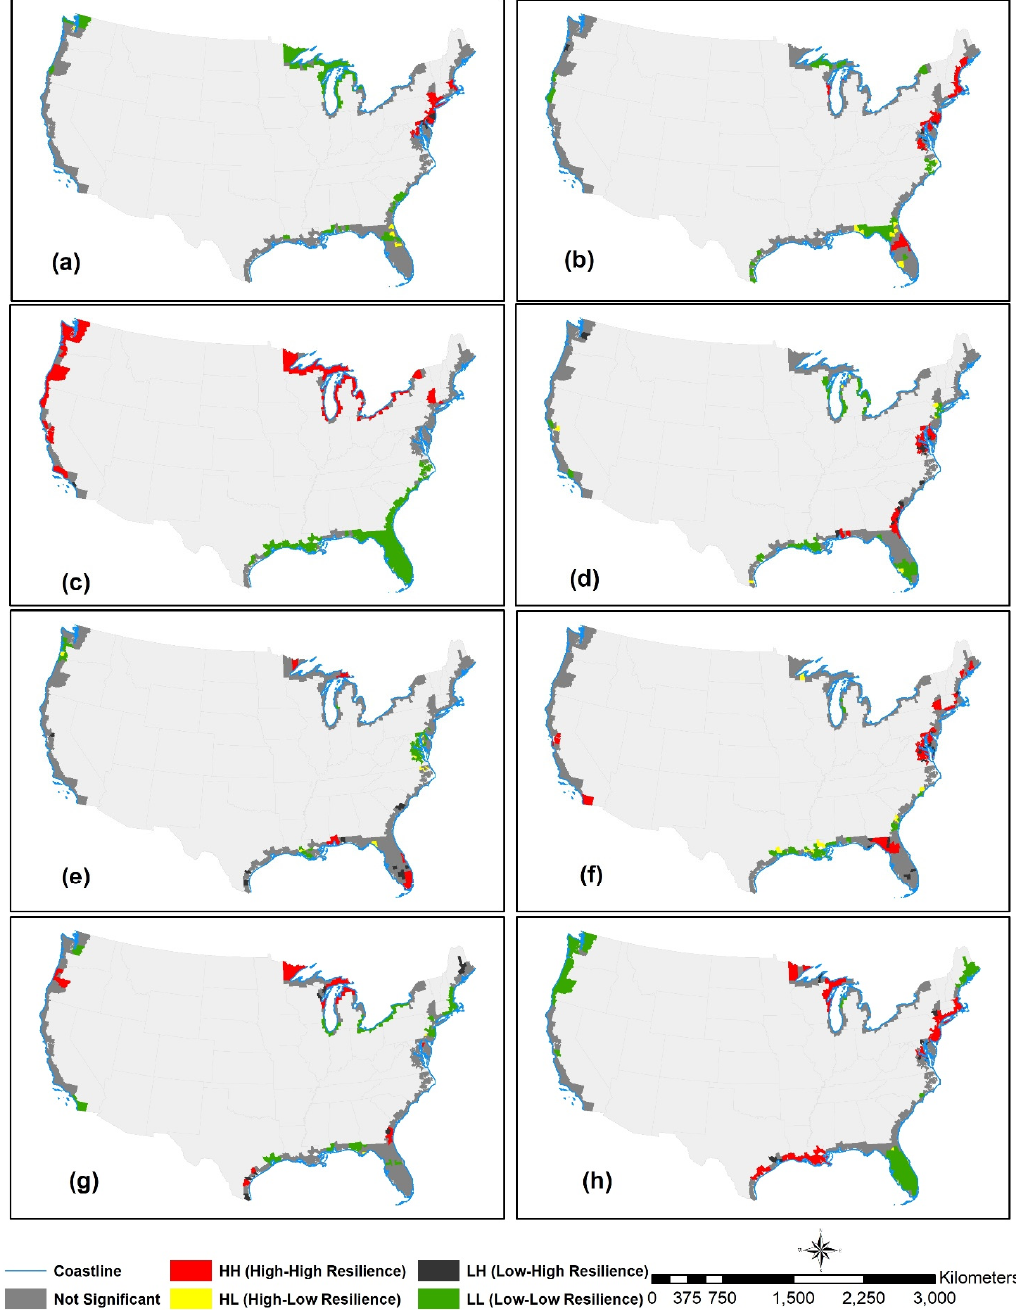
Figure 3. Clusters of hot and cold spots of eight community resilience components: ( a ) community capital-environmental-infrastructural; ( b ) social-infrastructural; ( c ) social-environmental; ( d ) economic-community involvement; ( e ) housing-economic; ( f ) environmental-social; ( g ) environmental-community involvement; ( h ) community capital-environmental.